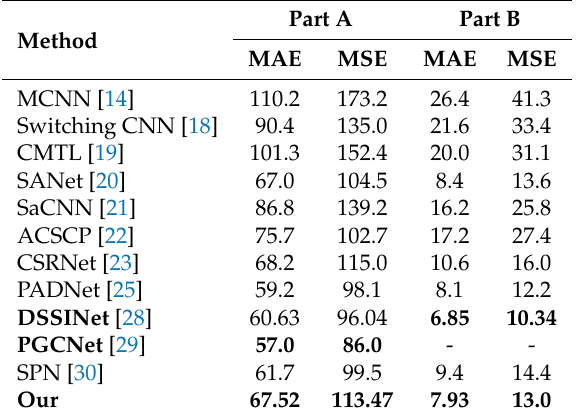
Table 5. ShanghaiTech part A and part B performance comparison.